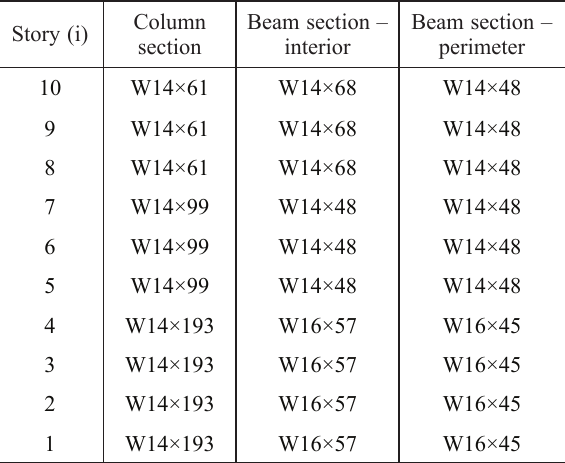
Table 4. Member data for vertically irregular – Moment Resisting frame (MRf)